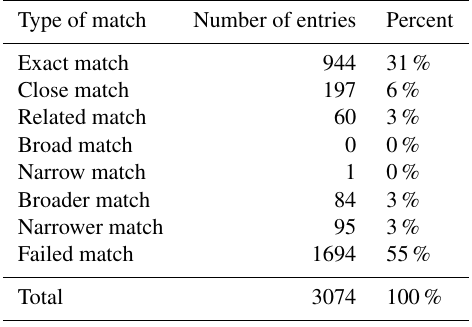
Table 3. Distribution of matches across the fuzzy string matching dataset. A total of 45% of the unique records are matched reason- ably, 31% of which are exact matches, 6% close matches, 3% re- lated matches, 3% Broader matches and 3% narrower matches.